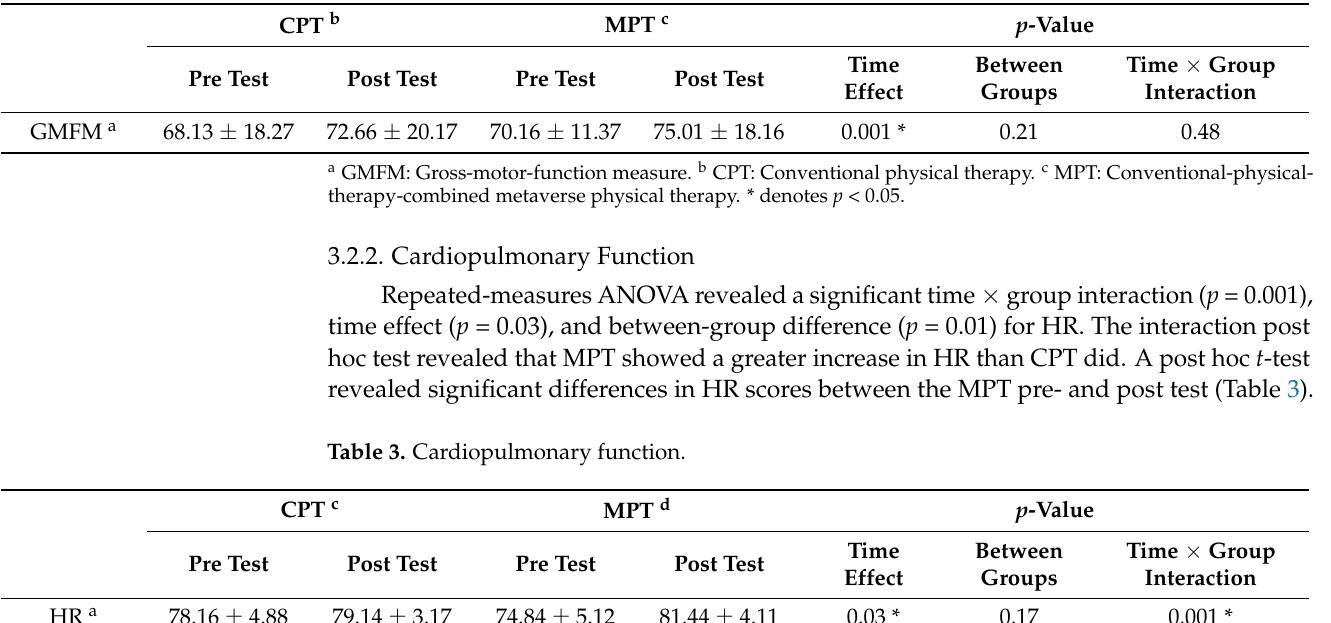
Table 2. Gross-motor-function measure.